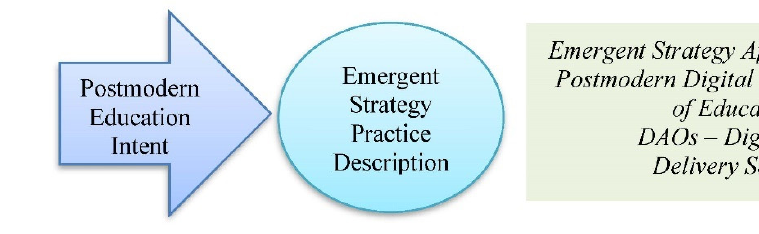
Figure 10. Emergent Strategy is Displayed as the Realised Strategy. Source: Based on (Foss et al. 2021).